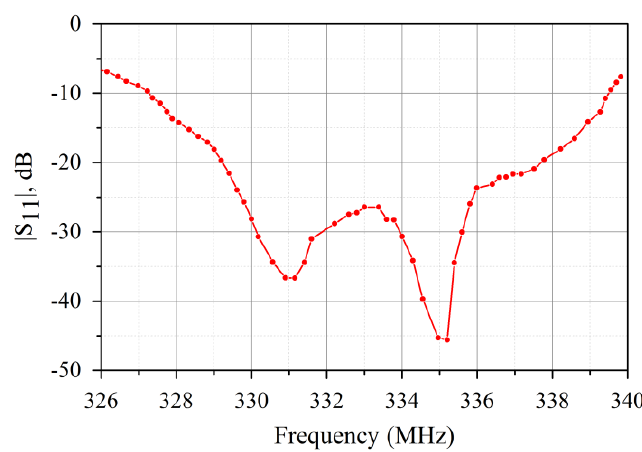
Fig. 3. Experimental frequency dependence of |S 11 | in the operating frequency range